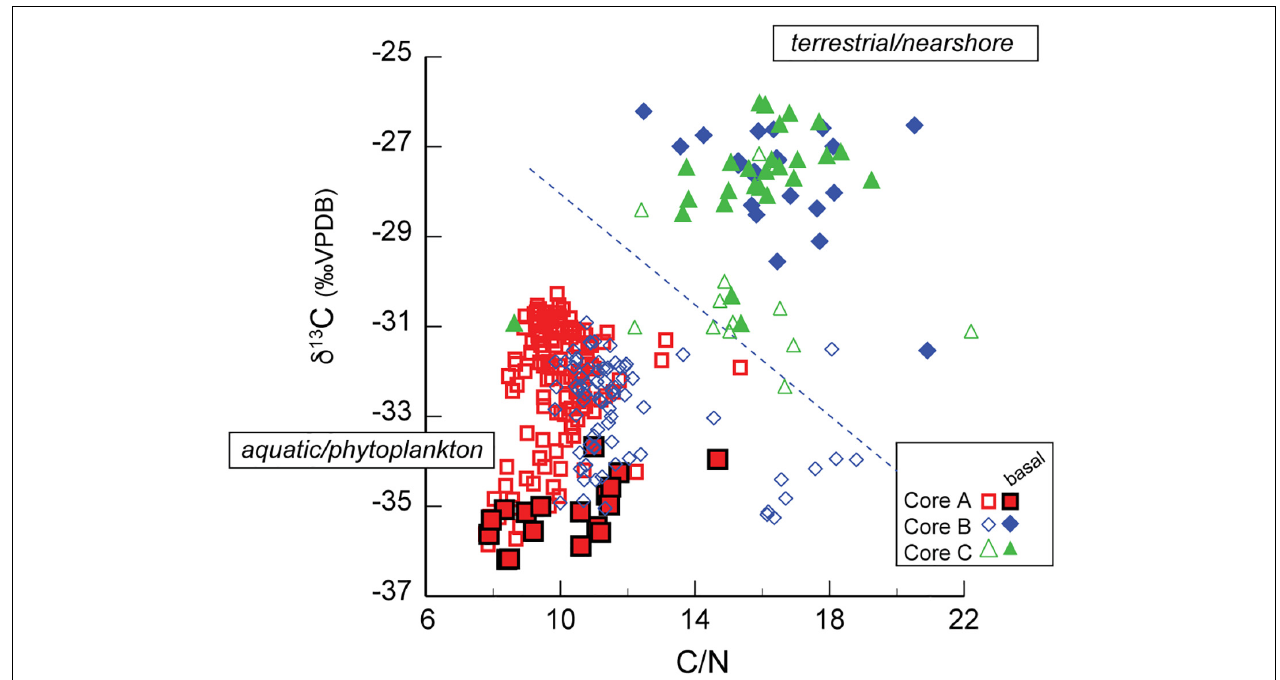
FIGURE 9 | Sediment core organic matter C/N ratios and δ 13 C values with a delineation between aquatic/phytoplankton and terrestrial/nearshore organic carbon sources. Symbols for core A are red squares, core B are blue diamonds, and core C are green triangles, with solid symbols for basal sediments and open symbols for lacustrine